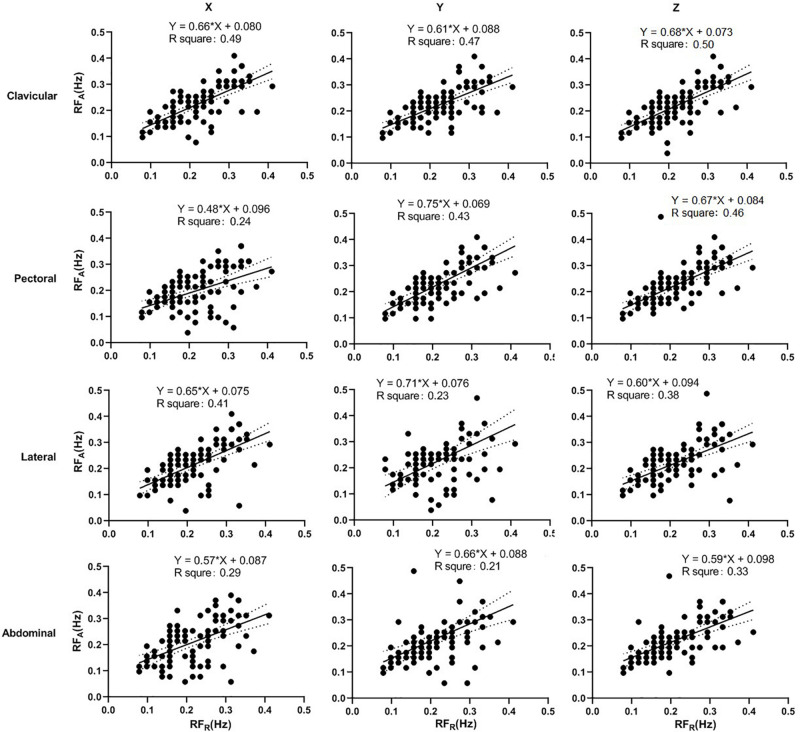
Linear regression of the accelerometer-derived and reference RFs in seated posture. The x- and y-axes denote the reference and accelerometer-derived RFs, respectively. The points mark the measured data. The solid and dotted lines indicate the best-fit line and its 95% confidence interval, respectively.